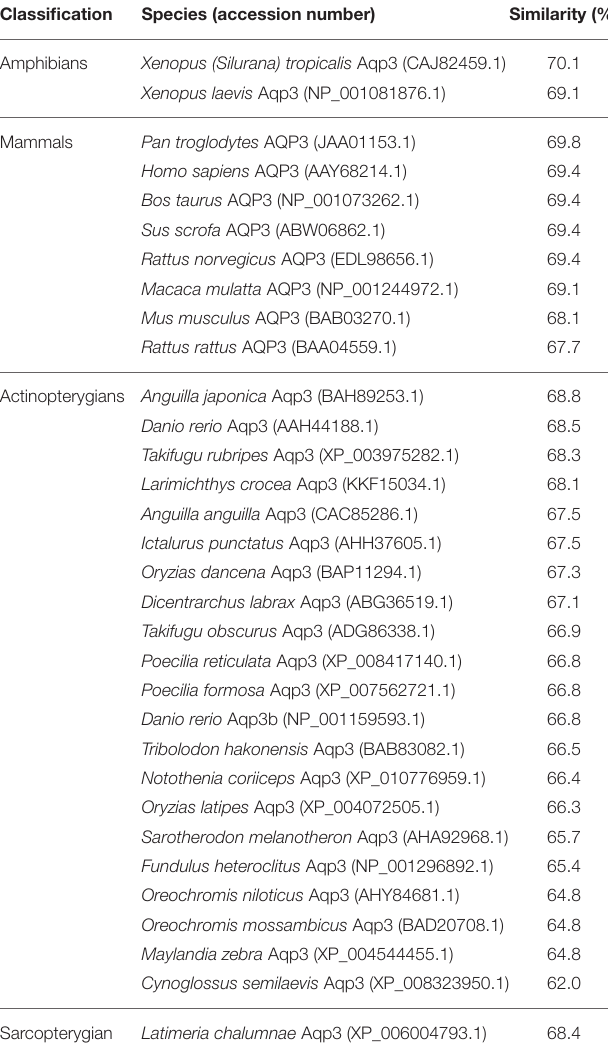
TABLE 3 | The percentage similarity, arranged in a descending order, between the deduced amino acid sequence of aquaporin 3 (Aqp3) from Protopterus annectens and Aqp3/AQP3 sequences from other animal species obtained from